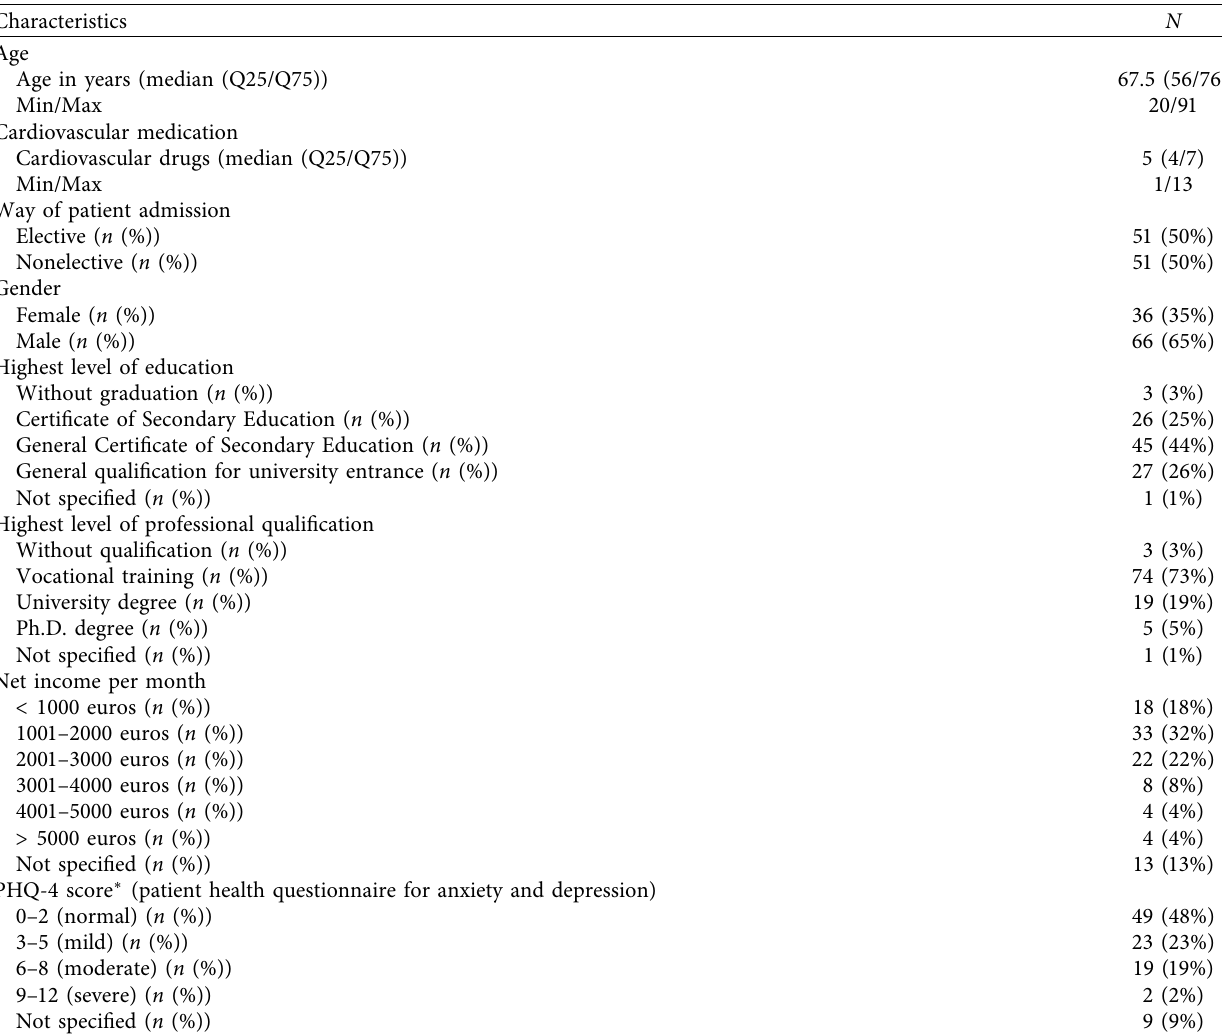
Table 1: Patient